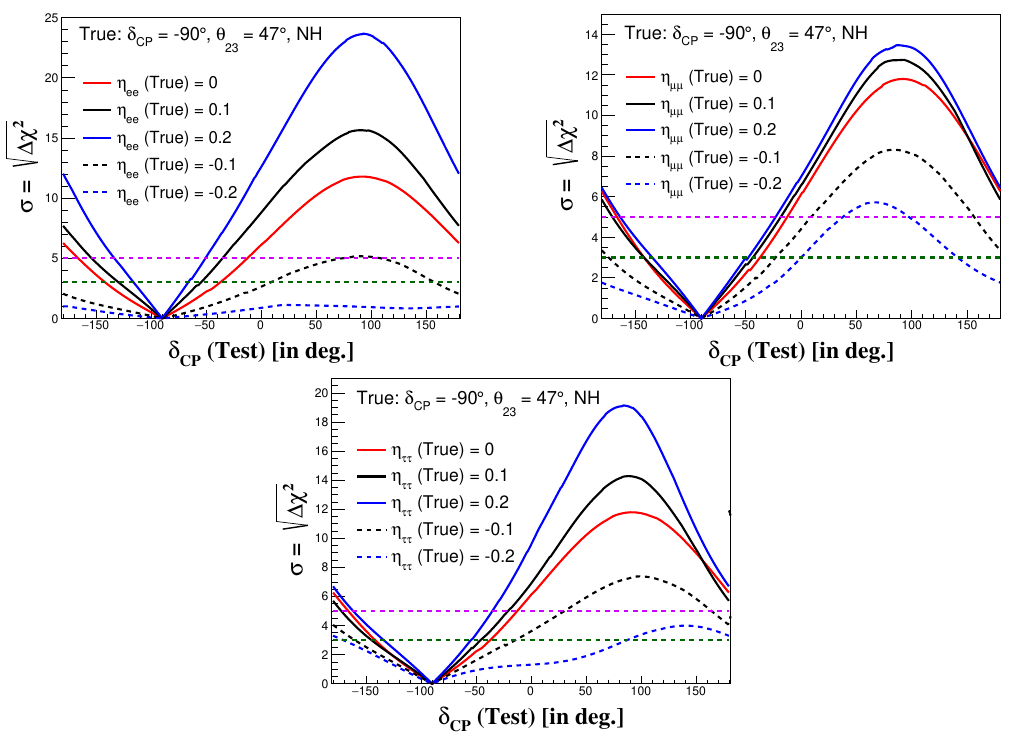
Figure 7 . The CP-precision sensitivity in presence of η αβ for true δ CP = − π /2 and true θ 23 = 47 ◦ . We show the results for η ee (top-left panel), η µµ (top-right panel) and η ττ (bottom panel). In all the three plots, the red line is for the SI